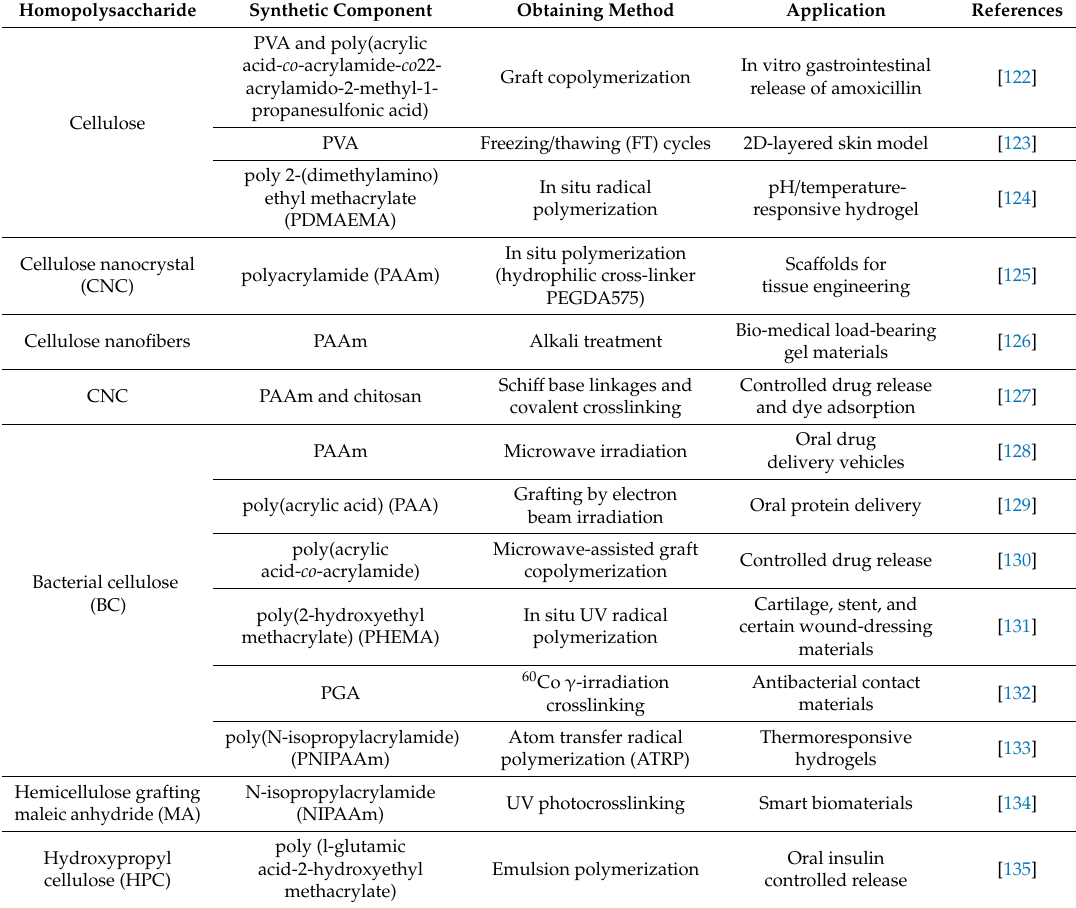
Table 2. Examples of homopolysaccharide-based organic hybrid hydrogels, their obtaining methods and medical